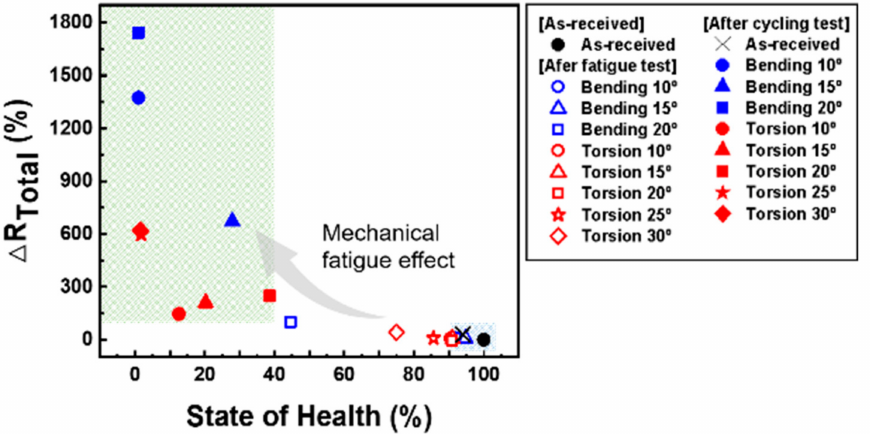
Figure 7. Plot of the relation between ∆ R Total and SoH under various test conditions.